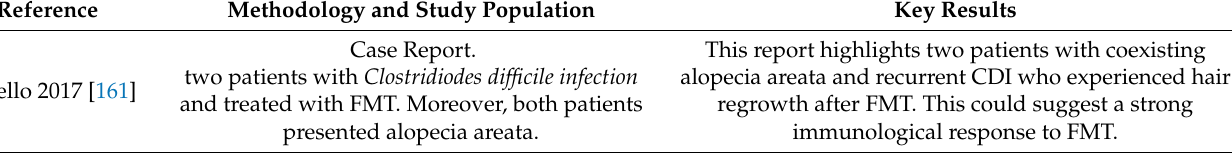
Table 2. Main gut microbiota-related studies in patients with alopecia areata. FMT: Faecal